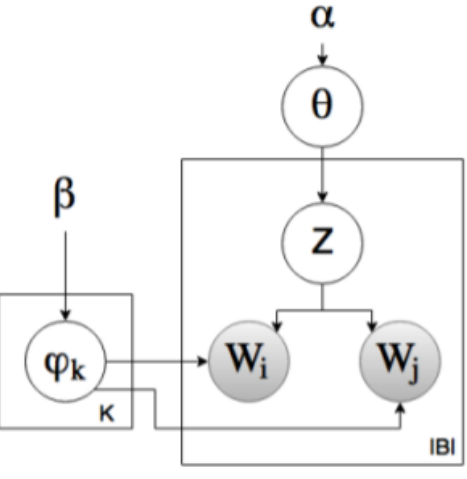
Figure 3. The graphical representation of the BTM